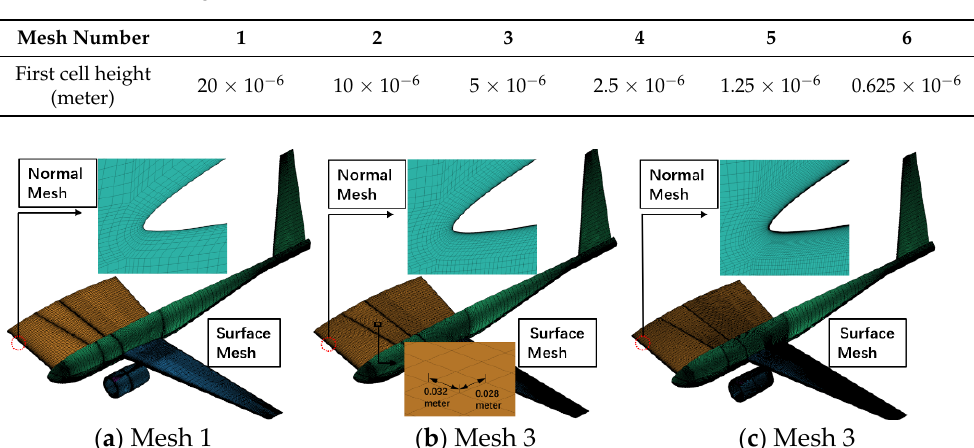
Table 2. First cell height condition.